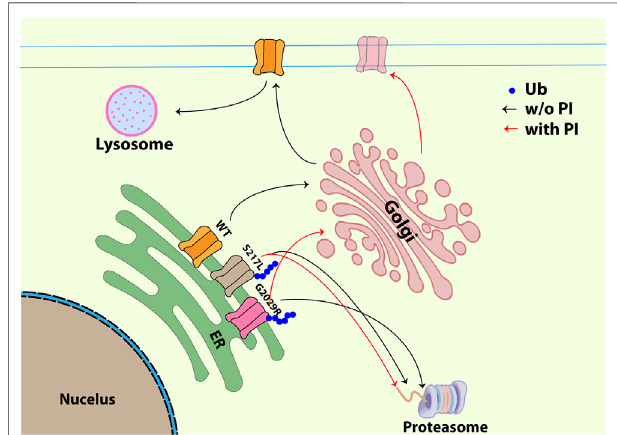
FIGURE 6 | Schematic fi gure illustrating the traf fi cking pathway for WT, S217L and G2029R with or without ALLN. WT Piezo1 transits from ER to plasma membrane and is fi nally degraded through membrane-protein internalization and lysosome dependent degradation. Unlike the WT Piezo1, both S217L and G2029R Piezo1 go through ubiquitination and proteasome dependent degradation. Treatment with the proteasomal inhibitor ALLN did not in fl uence the membrane localization of S217L, while G2029R was partially rescued exhibiting increased membrane labelling and increased amplitudes of mechanically-evoked currents. Black arrow indicates the traf fi cking pathway for all Piezo1 proteins without ALLN treatment; red arrow indicates the traf fi cking pathway for S217L and G2029R Piezo1 after ALLN treatment (Ub-ubiquitin, P/I-proteasomal